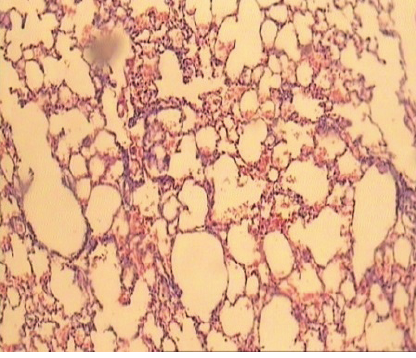
FIGURE 1 - Representative photomicrograph from lungs of the group I.